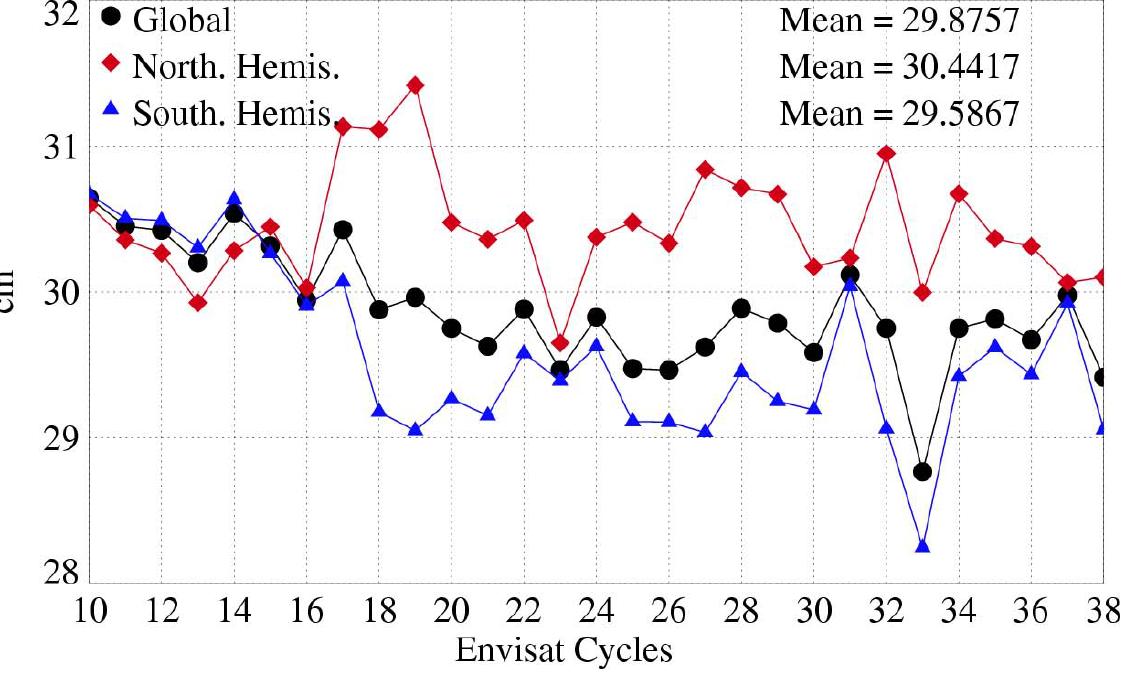
Figure 19. Mean of Envisat –Jason-1 differences at 10-day dual crossovers. Dots: Global. Diamonds: Northern Hemisphere. Triangle: Southern